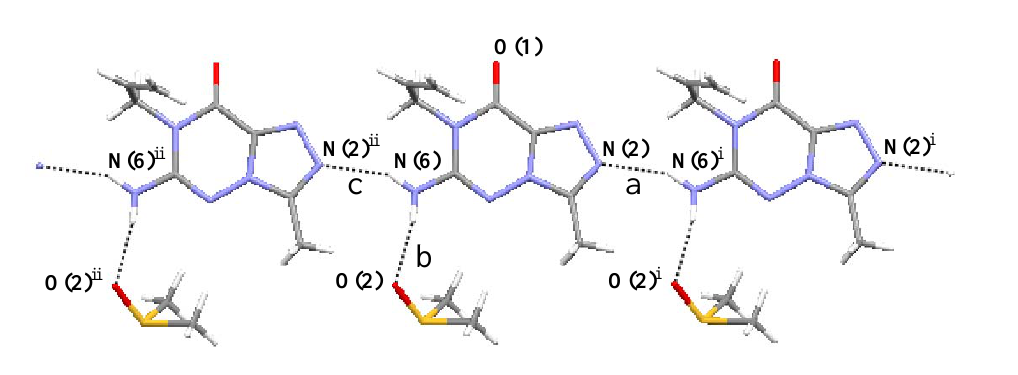
Figure 3. A part of the crystal structure for molecule 3 , showing the molecules’ direction along the a -view with x+90°. Broken lines indicate the intermolecular hydrogen bonding patterns. For notation and symmetry codes see Table 1.